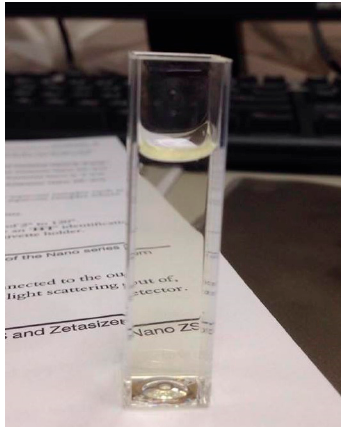
Figure 4. Appearance of microemulsion containing sesame oil, PEG400, Tween80 and water. Table 2. Particle size of liquid SMEDDS with and without 10% albendazole (mean ± SD, n = 3). Liquid SMEDDS Particle Size (nm) Polydispersity index